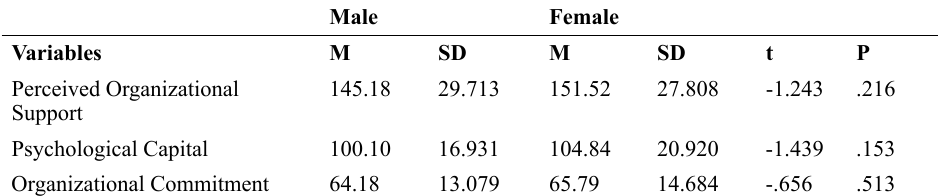
Psychological Capital & Organizational Commitment.